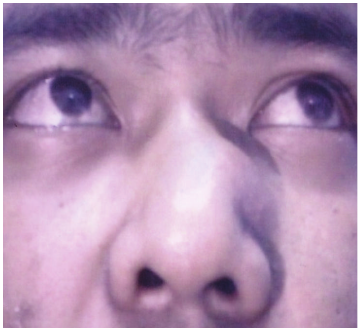
Figure 1: Left nasal bridge swelling.